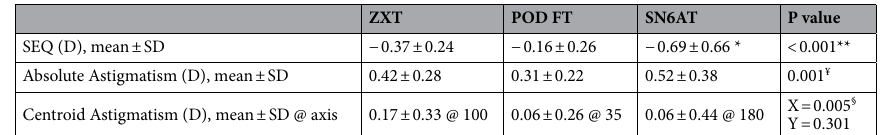
Table 6. Postoperative manifest refraction outcomes. D diopters, SEQ spherical equivalent. *Including monovision. **SN6AT < ZXT, POD FT. ¥ POD FT < SN6AT. § ZXT < SN6AT.